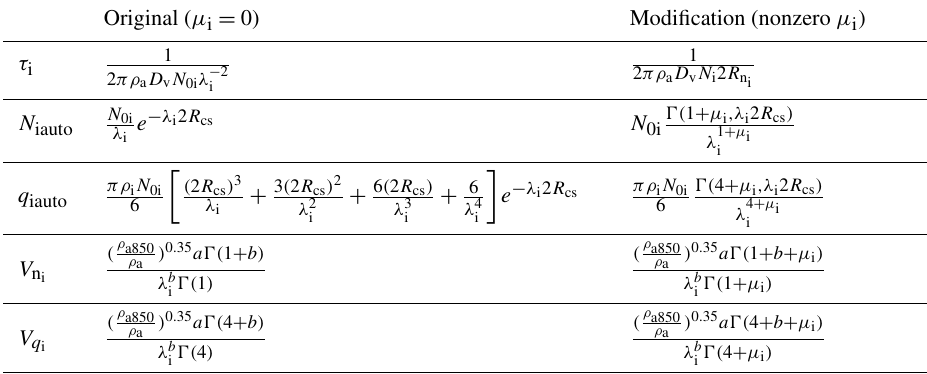
Table 1. Equations for calculating the µ i -related cloud microphysical processes ∗ .